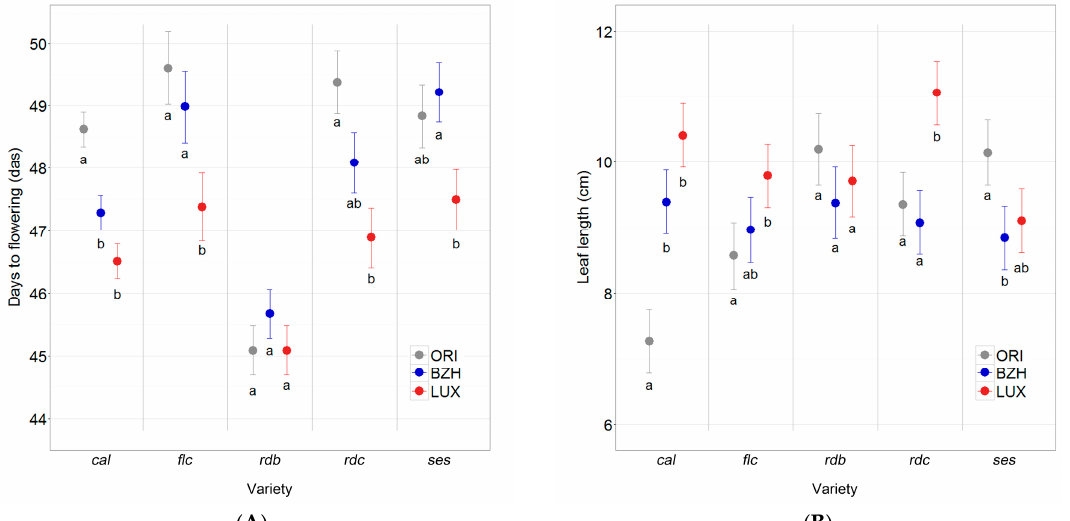
Figure 5. ( A ) Days to flowering in days after sowing (das); and ( B ) Leaf length (cm) of the 15 bean populations belonging to the five studied varieties. Error bars represent standard errors of the means. Within each variety, populations that are not marked with the same lowercase letter differ significantly.